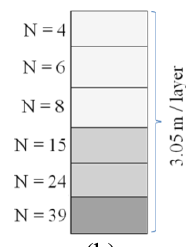
Fig. 1. Sandy soil samples; (a) Several multilayered sandy soils with varying density (b) Soil S Soil parameters of different states of sand layers [Mohr Coulomb Model].